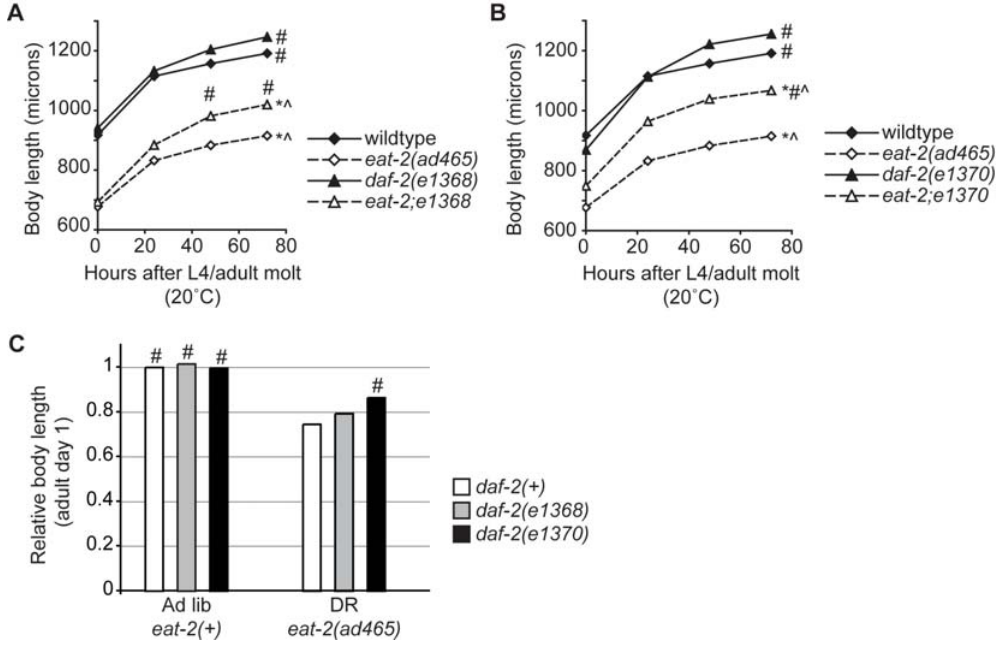
Figure 4. Small body size caused by DR was partially suppressed in daf-2mutants. (A, B) Body length increased over the first 3 days of adulthood under both DR and non-DR conditions. Wildtype animals under DR conditions were approximately 30% shorter than under non-DR conditions (diamonds). Under non-DR conditions, daf-2(e1368) and daf-2(e1370) adults were slightly longer than wildtype animals (dark shapes) and daf-2 mutant body size was also reduced under DR (triangles). However, eat-2;daf-2 animals grew to larger sizes than eat-2 animals (open triangles vs open diamonds). (C) Composite graph of adult body length of wildtype and daf-2 mutants under DR and non-DR conditions on adult day 1 (24-hours post- molt), plotted relative to wildtype non-DR adults. All body length measurements were conducted at 15˚C and animals were synchronized by chronological age from hatching. For each time point, measurements of 10–14 animals for each strain were averaged from 3 independent experiments, except for eat-2(ad465); daf-2(e1368) animals for which 2 experiments were conducted. Statistical significance was evaluated by t-test and indicate significance in at least 3 of 4 timepoints, *p , 0.01 vs wildtype in all trials, # p , 0.01 vs eat-2(ad465) in all trials, ˆ p , 0.01 vs daf-2(e1368) (A) or daf-2(e1370) (B) in all trials ; p , 0.0001 (t-test) for all 3 strains at each time point except for eat-2(ad465) vs eat-2(ad465); daf- 2(e1370) at 0 and 8 hours (p=0.076 and 0.089, respectively). In addition, in (A) eat-2(ad465); daf-2(e1368) vs eat-2(ad465) body lengths were statistically significant (p , 0.01) at only the 48 and 72 hour timepoints of all trials.